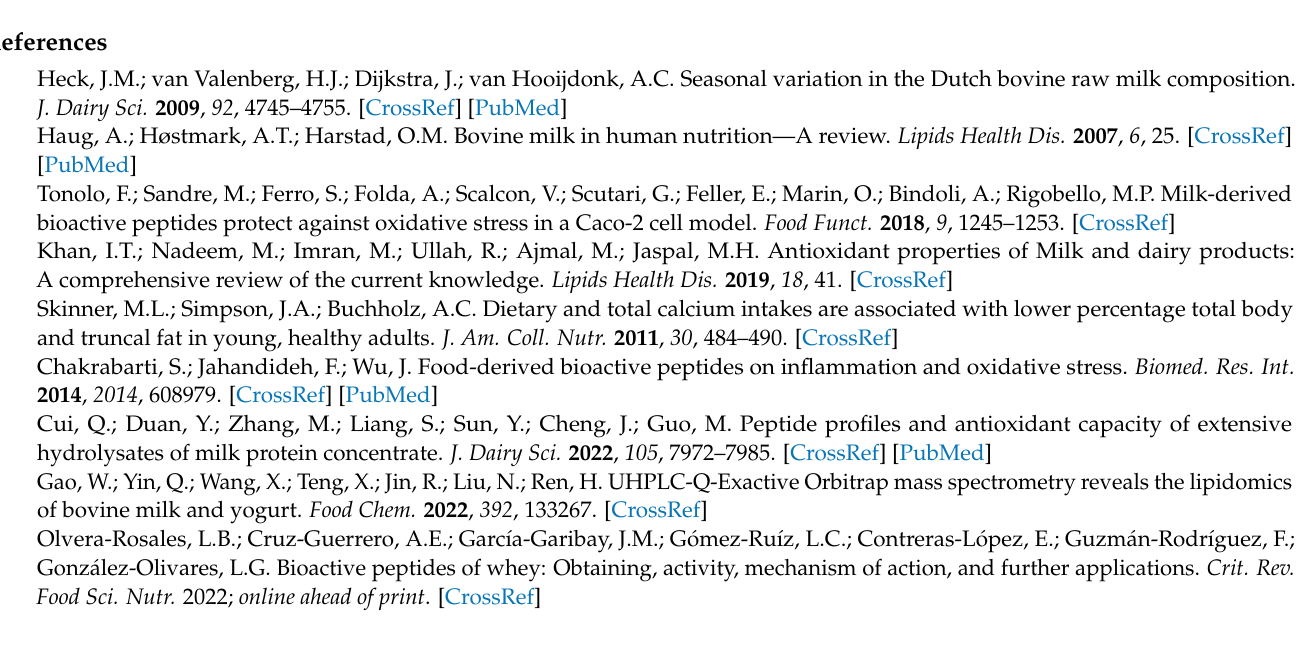
Figure S2: Oxidative stress controls, Figure S3: Apoptotic markers, Figure S4: mRNA levels of ER-stress markers, Figure S5: ER-stress markers, Figure S6: ER-i